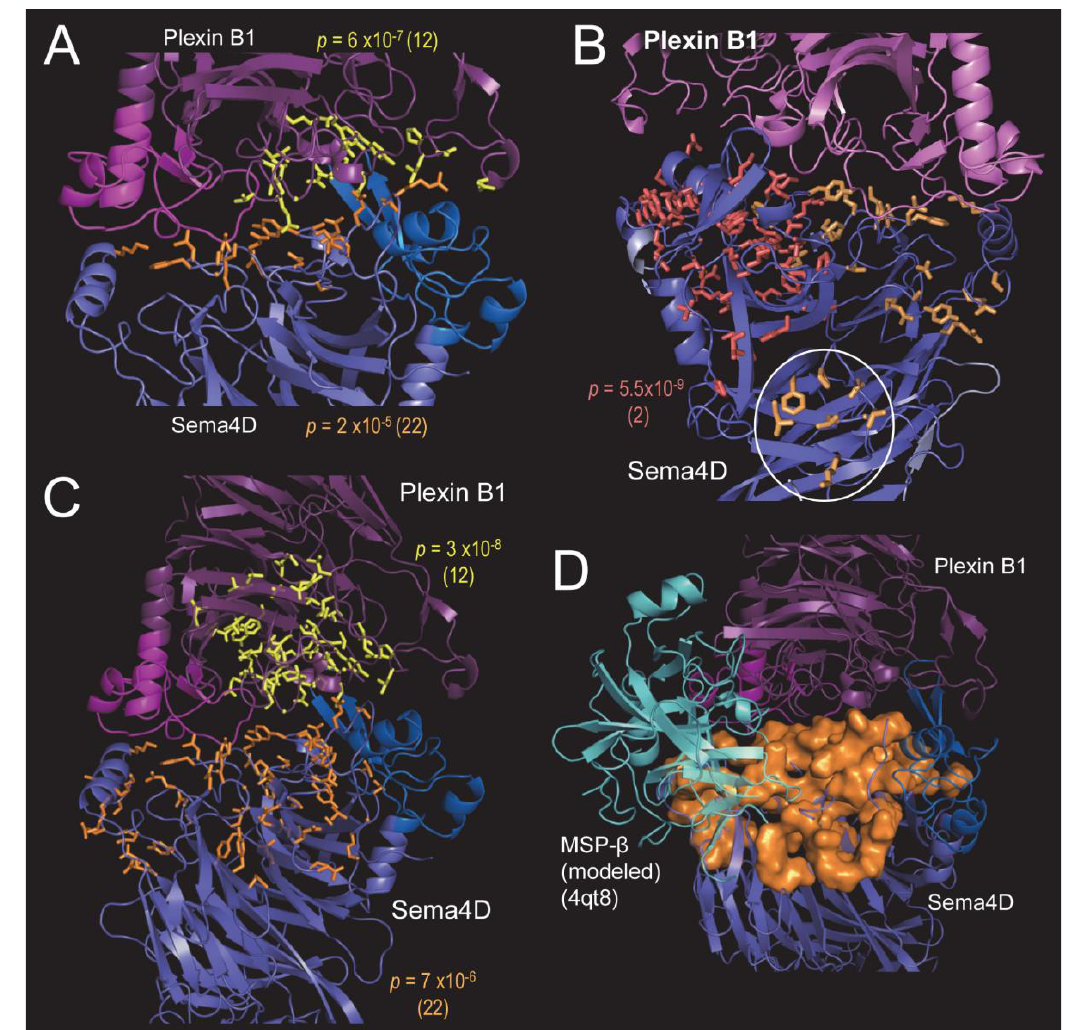
Figure 5. BPPS-SIPRIS analyses of the Sema4D – PlexinB1 complex (pdb_id: 3ol2). ( A ) BPPS-SIPRIS analysis identifying Sema4D- and PlexinB1-specific residues significantly clustered at the Sema4D – PlexinB1 interface; p -values and, in parentheses, the corresponding node IDs are indicated. Shown in orange are Sema4D residues contacting Plexin B1 and in yellow Plexin B1 residues contacting Sema4D. ( B ) Sema4D family- and subfamily-specific residue clusters identified by BPPS-SIPRIS (residue sidechains shown in red and orange, respectively). Two subfamily clusters were found: adjacent to the Plexin B1 interface and another at the Sema4D homodimeric interface (circled). ( C ) BPPS-SIPRIS analysis identifying Sema4D- and PlexinB1-specific residues significantly clustered within each subunit. ( D ) The Sema4D-specific residues in panel C (orange space-fill) are relative to a modeled interaction with MSP- β subunit. Bound MSP- β was modeled by structurally superimposing, over Plexin B1, the Ron Sema domain + MSP- β complex (pdb_id: 4qt8). Although merely hypothetical, this suggests that the larger Sema4D surface in panel C may facilitate binding of other cellular